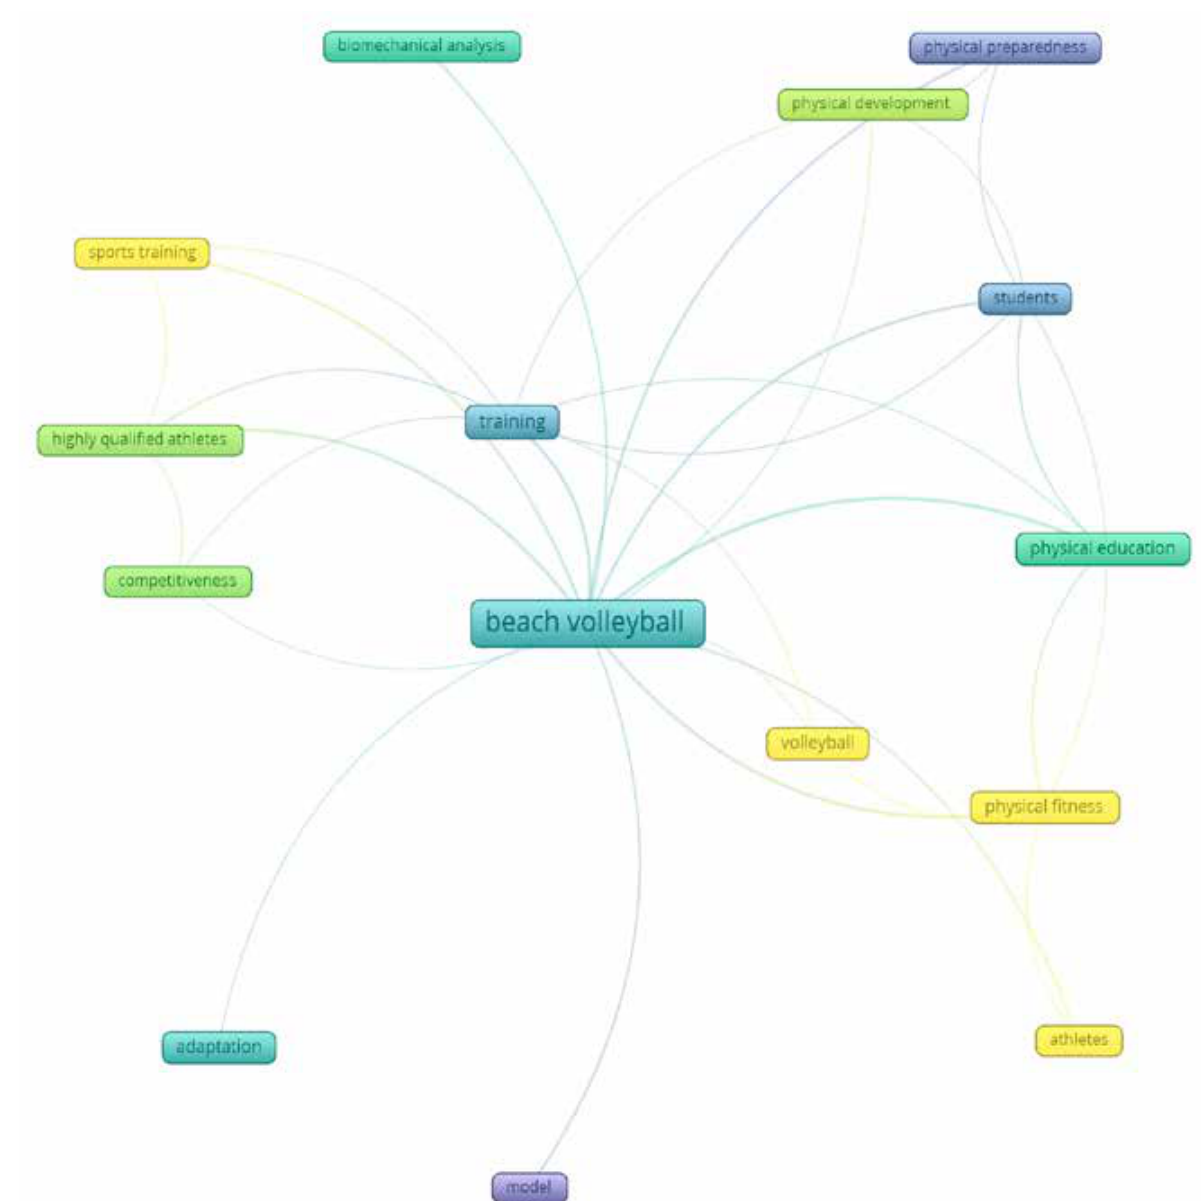
Figure 6. Data visualization by keywords (source: own research based on extracted data from SEL database and analyzed with VOSviewer;